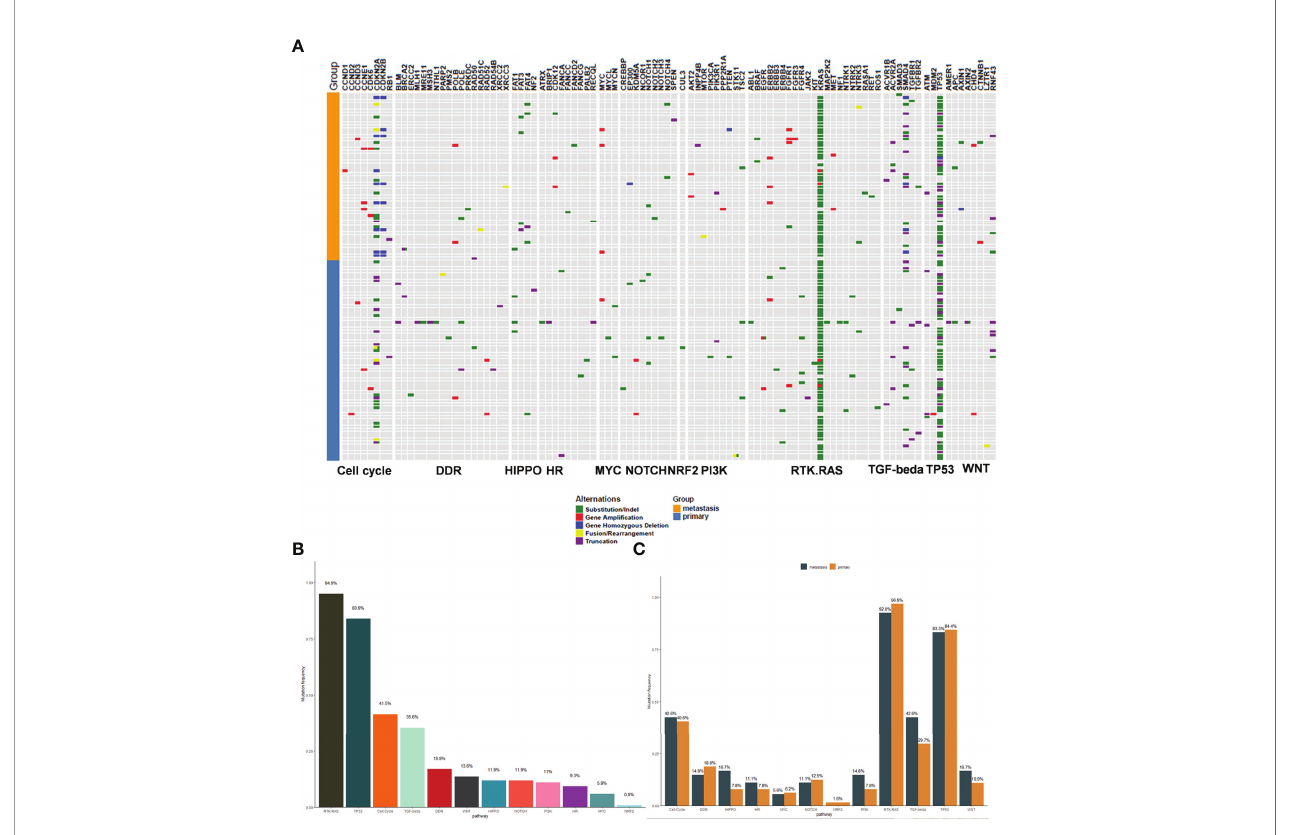
FIGURE 2 | The signaling pathway involved in the mutant genes. (A) The map of mutant genes and the involved signal pathways. Light blue represents the primary tumors and orange represents the metastatic tumors. The upper panel shows the mutant genes and the lower panel shows the signal pathways. Green; Substitution/ Indel, Red; Gene ampli fi cation, Blue; Gene homozygous deletion, Yellow; Fusion/Rearrangement, Purple; Truncation. (B) The mutation frequency of the signaling pathways involved in the mutant genes. (C) The comparison of mutation frequency of the signaling pathways between primary and metastatic